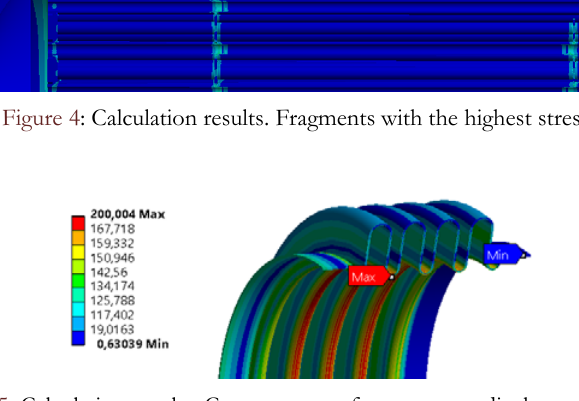
Figure 5: Calculation results. Compensator of temperature displacements,